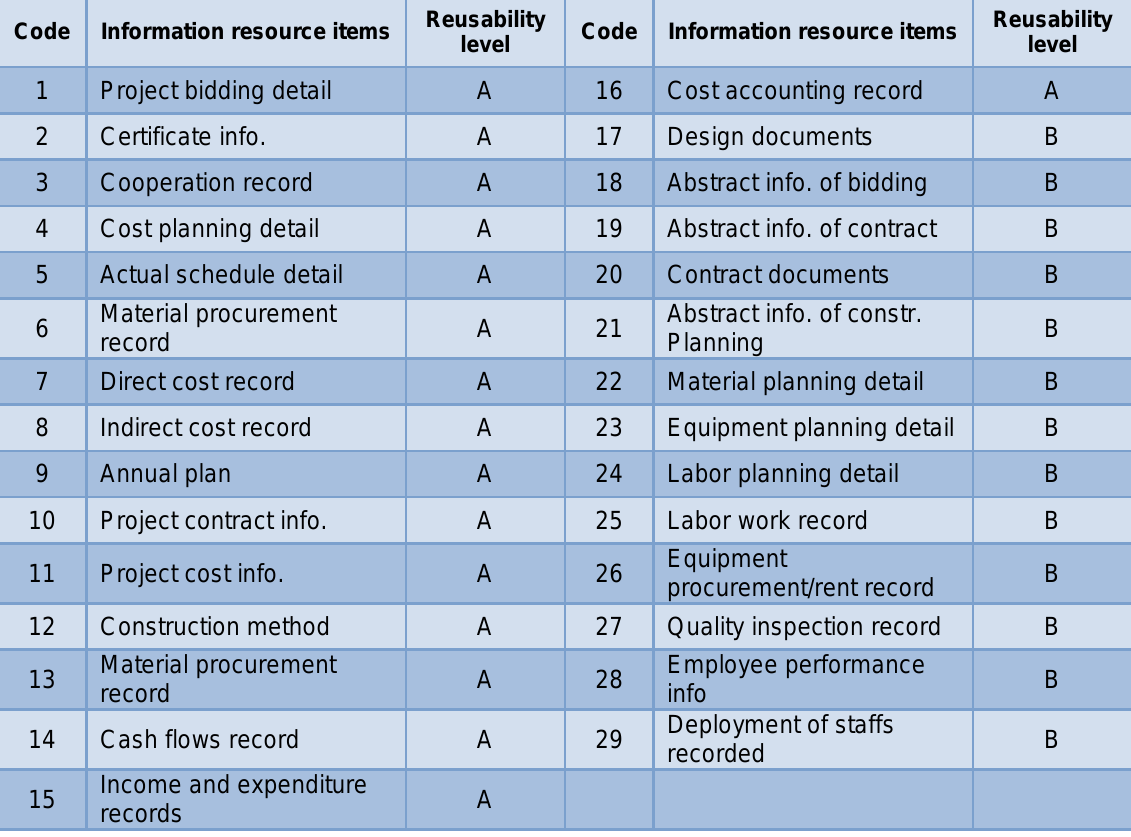
Table 1 Partial information resource items (Ma 2010b) Representation of Information